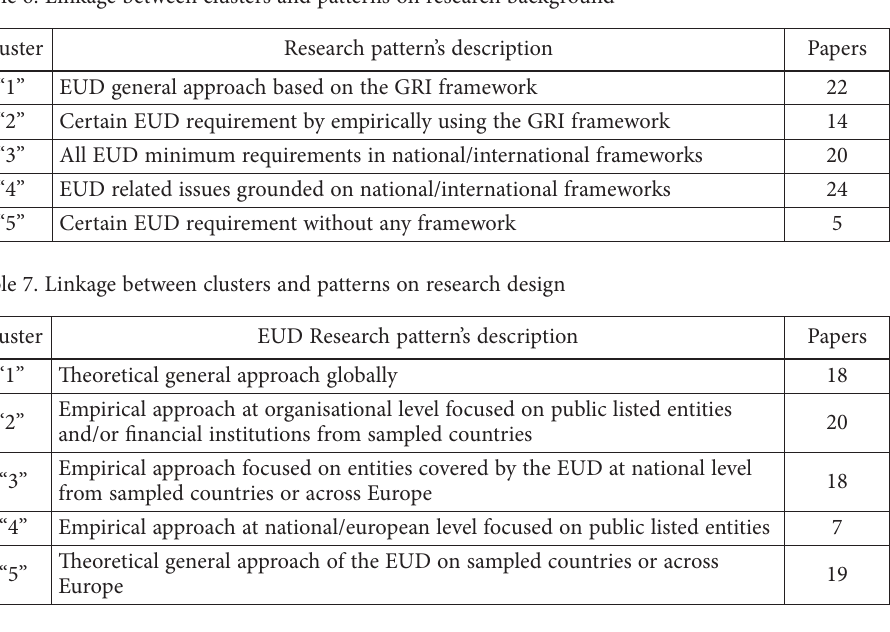
Table 6. Linkage between clusters and patterns on research background Cluster Research pattern’s description Papers